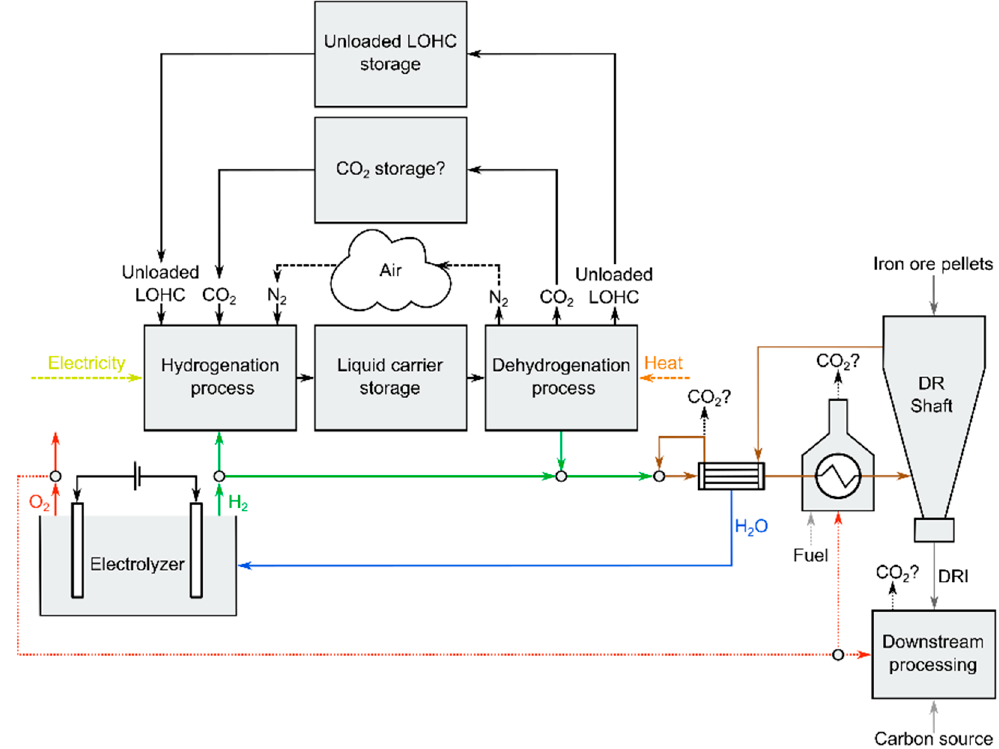
Figure 1. Schematic representation of the integration of various liquid hydrogen carriers in an H-DR process. Possible CO 2 sources are indicated (separation from DR process reducing gas, oxy-fuel combustion reducing gas pre-heating, separation from downstream processing steps).